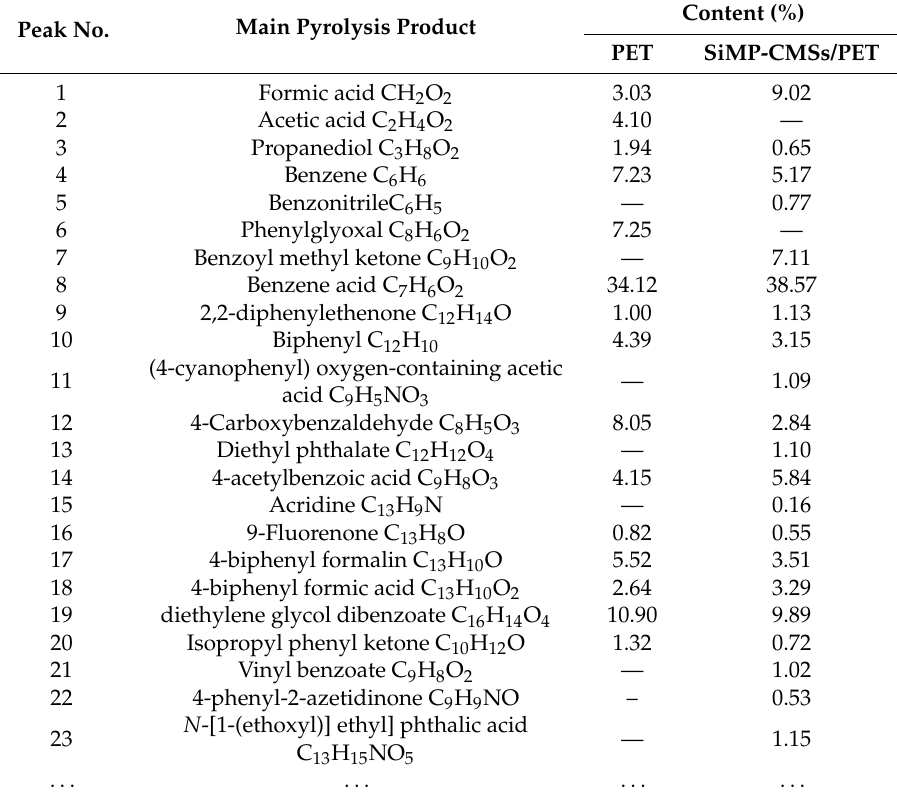
Table 6. Main pyrolysis products of SiMP-CMSs/PET